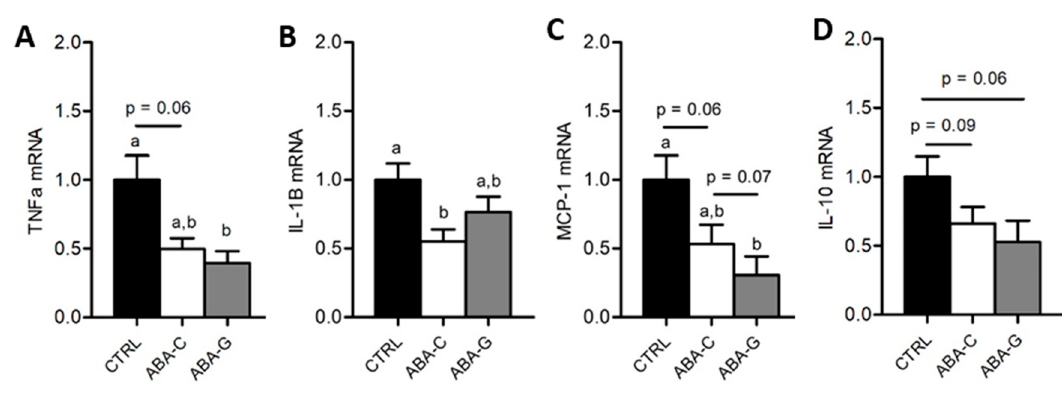
Figure 5. mRNA levels of colonic cytokines. The mRNA levels of colonic pro- and anti-inflammatory cytokines were evaluated by RT-qPCR for Gln experimentation: TNF- α ( A ), IL-1 β ( B ), MCP-1 ( C ) and IL-10 ( D ). Column bar graphs showed control mice (CTRL; black bars, n = 16), non-supplemented activity-based anorexia mice (ABA-C; open bars, n = 16) and supplemented activity-based anorexia mice (ABA-G; grey bars, n = 12). Values without a common letter significantly differ ( p < 0.05).